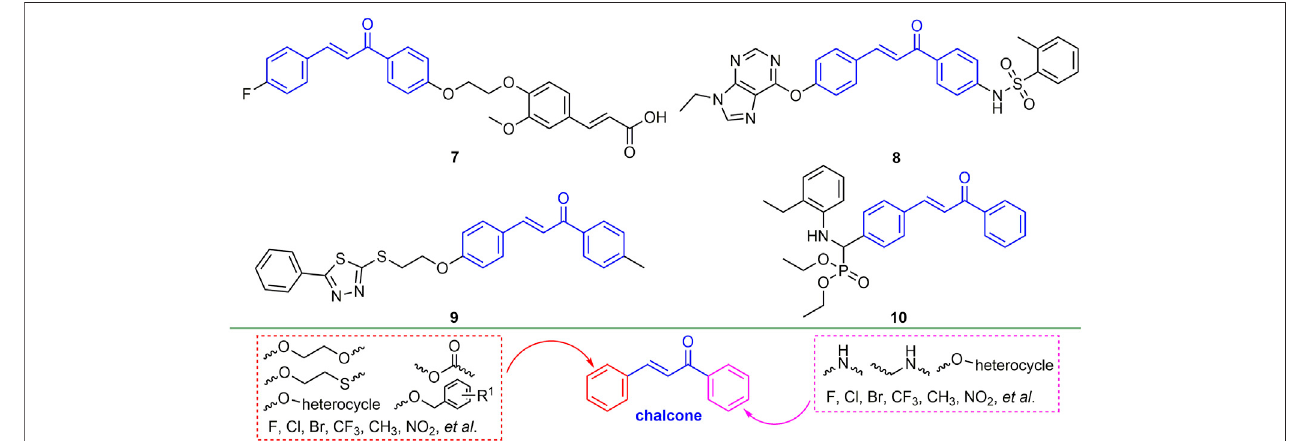
FIGURE 4 | Structures of representative chalcone derivatives in antiviral activities.